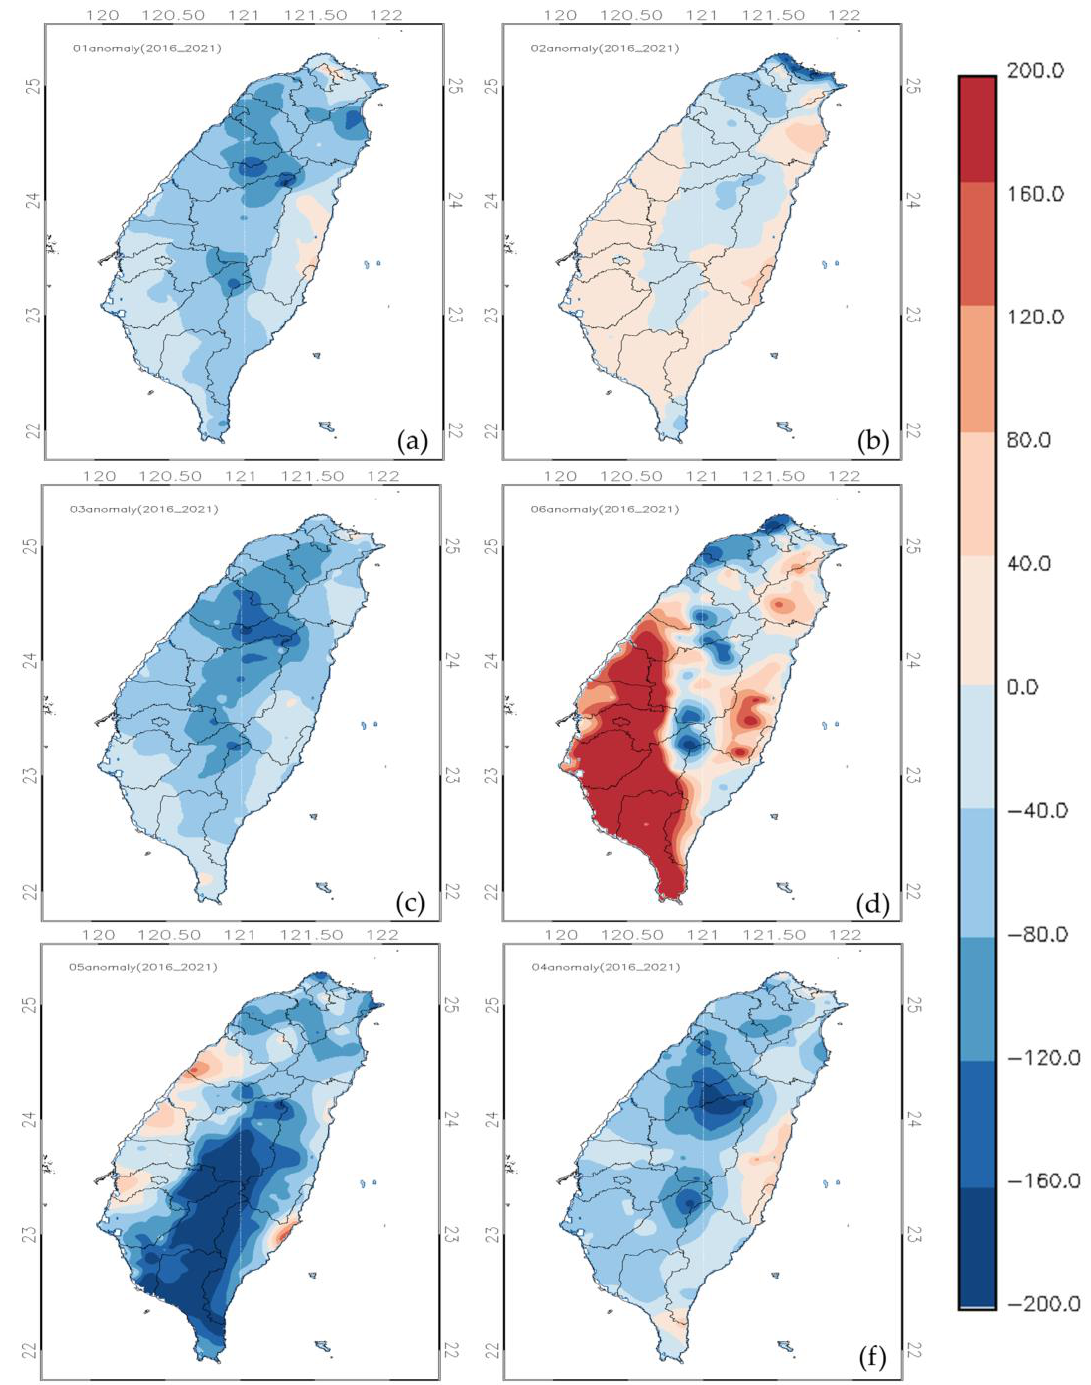
Figure 5. The anomaly in percentage of precipitation from January to June 2021(from ( a – f )). The color scales are shown on the right.